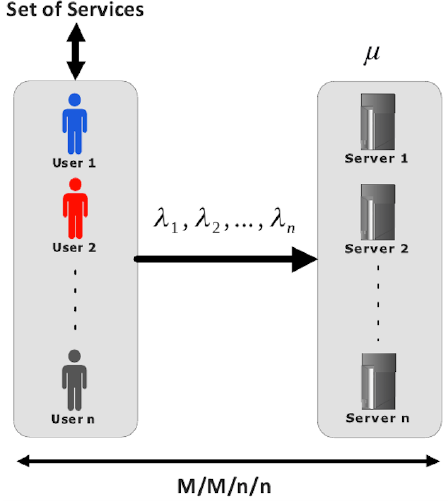
Figure 1. Erlang-Loss System